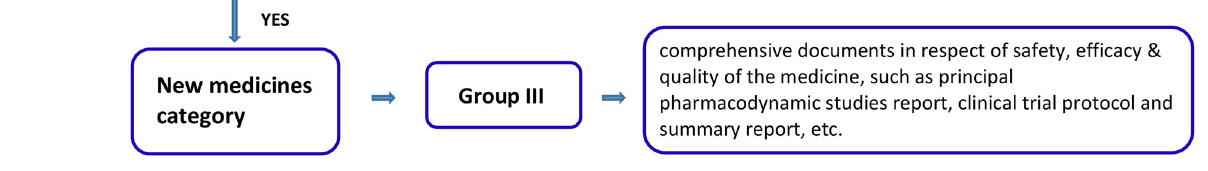
FIGURE 1 | The classification categories and registration groups of Proprietary Chinese Medicines and their requirements in Hong Kong (8).